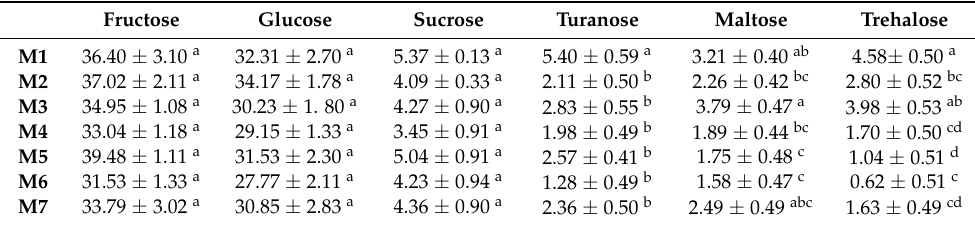
Table 3. Sugar content (g/100 g) of Euphorbia resinifera and Euphorbia officinarum monofloral honey samples from Morocco. The results of M2 and M3 samples were previously published [13]. Repro- duced with permission from Oumaima Boutoub et al., Antioxidant activity and enzyme inhibitory potential of Euphorbia resinifera and E. officinarum honeys from Morocco and plant aqueous extracts; published by Springer Nature,